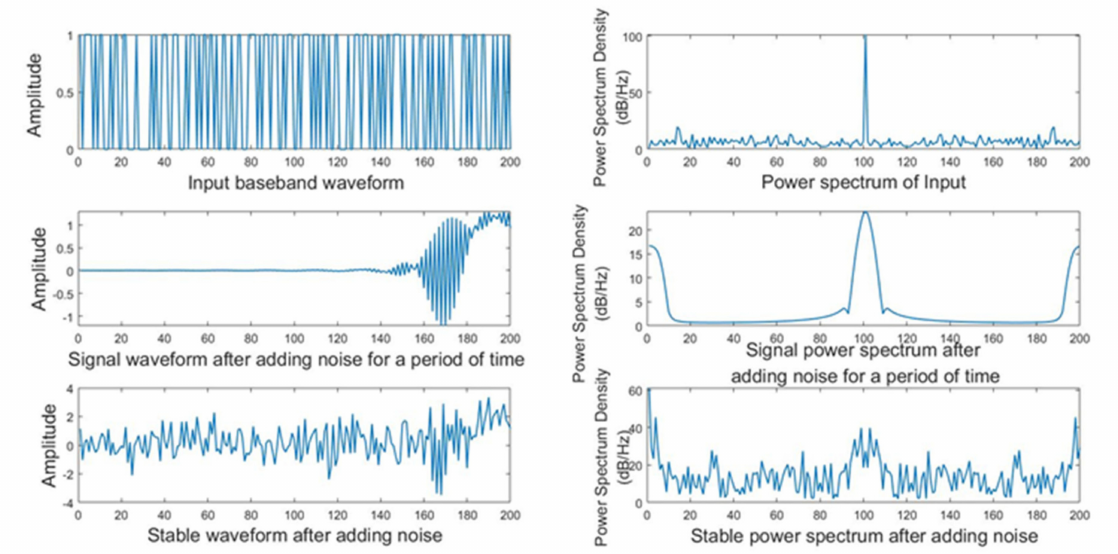
Figure 17. Signal performance diagram.